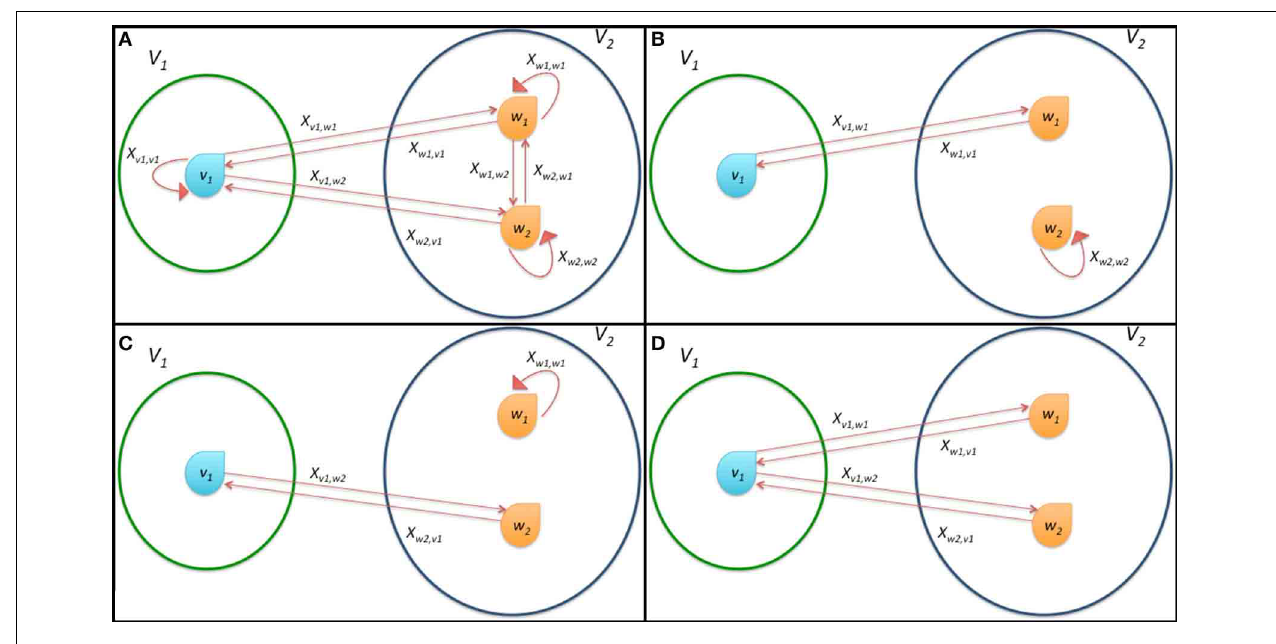
FIGURE 3 | Schematic representation of the connections among the bacteria in a simple system composed by only three microorganisms divided in the two classes V 1 and V 2 . (A) shows all possible connections, (B,C) report the effective